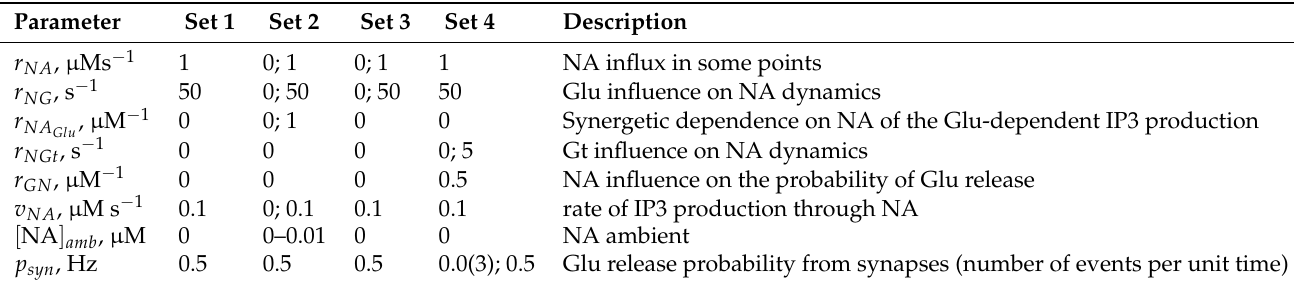
Table 1. Model parameters specific to described simulation